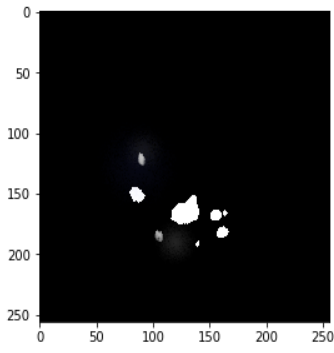
Figure 7. Final mask merged from both tumors.